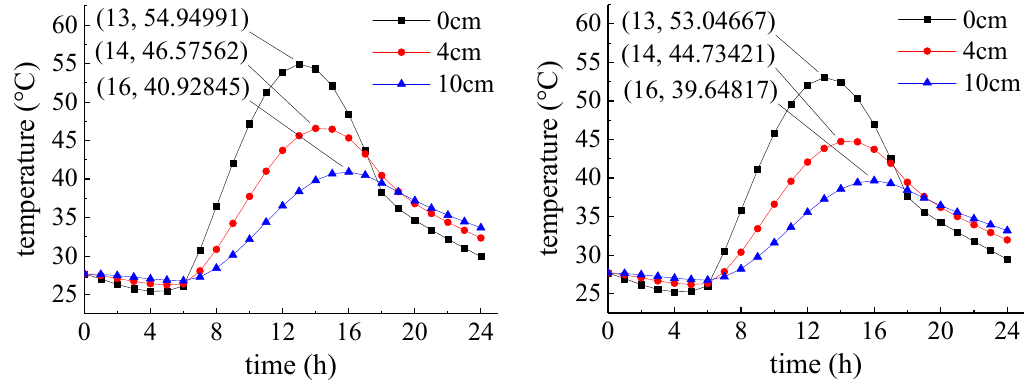
Figure 7. Temperature variation curves of each specimen at different depths.